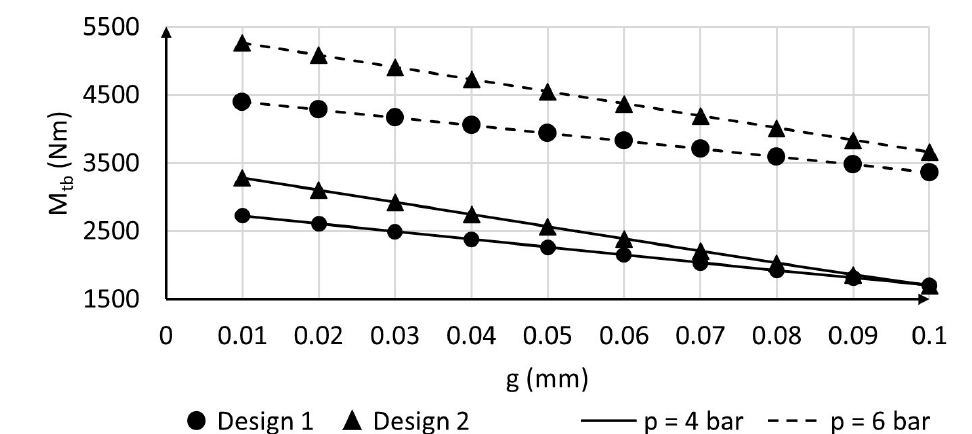
Figure 11. Clamping torque as a function of the gap g for different designs and pressure